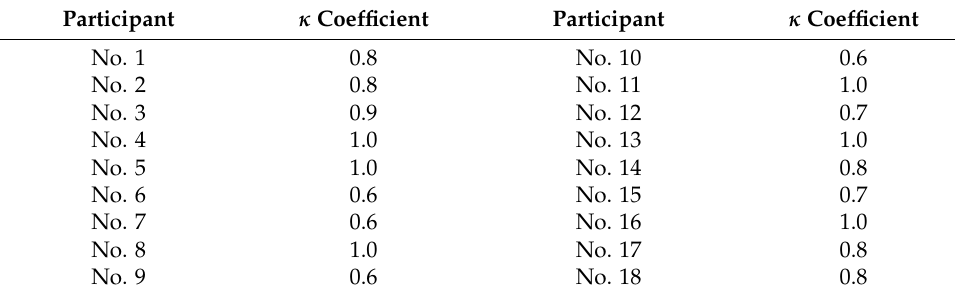
Table 1. The results of the test re-test reliability 1 . Participant κ Coefficient Participant κ Coefficient No. 1